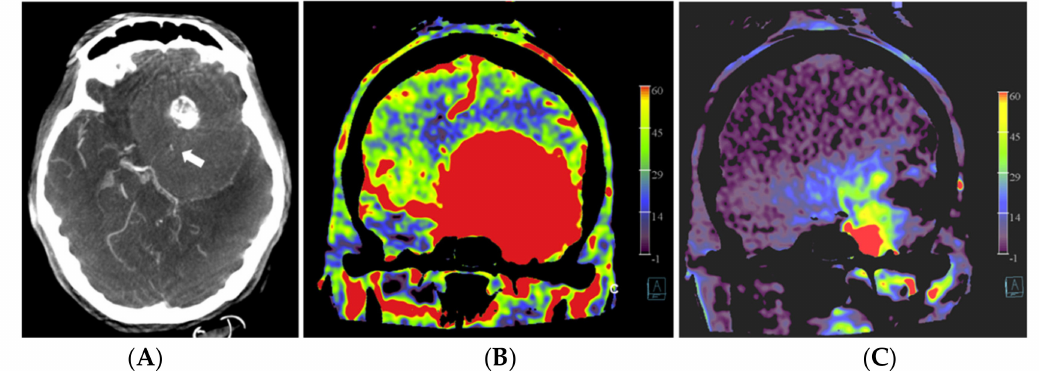
Figure 3. Patient no. 3 presented with a very large sphenoid ridge meningioma on the left side. ( A ) Axial 3 mm reformation based on fill run images shows the large tumor with encasement of the distal internal carotid artery (arrow) and the middle cerebral artery on the left. ( B ) Coronal reformation of whole brain PBV perfusion imaging compared to ( C ) coronal reformation of selective PBV perfusion by injection of the left external carotid artery shows predominant pial blood supply and only limited dural supply to the tumor. In this case, pre-operative embolization was not pursued because it was considered not helpful for reducing the surgery risk in comparison to the risk of the embolization